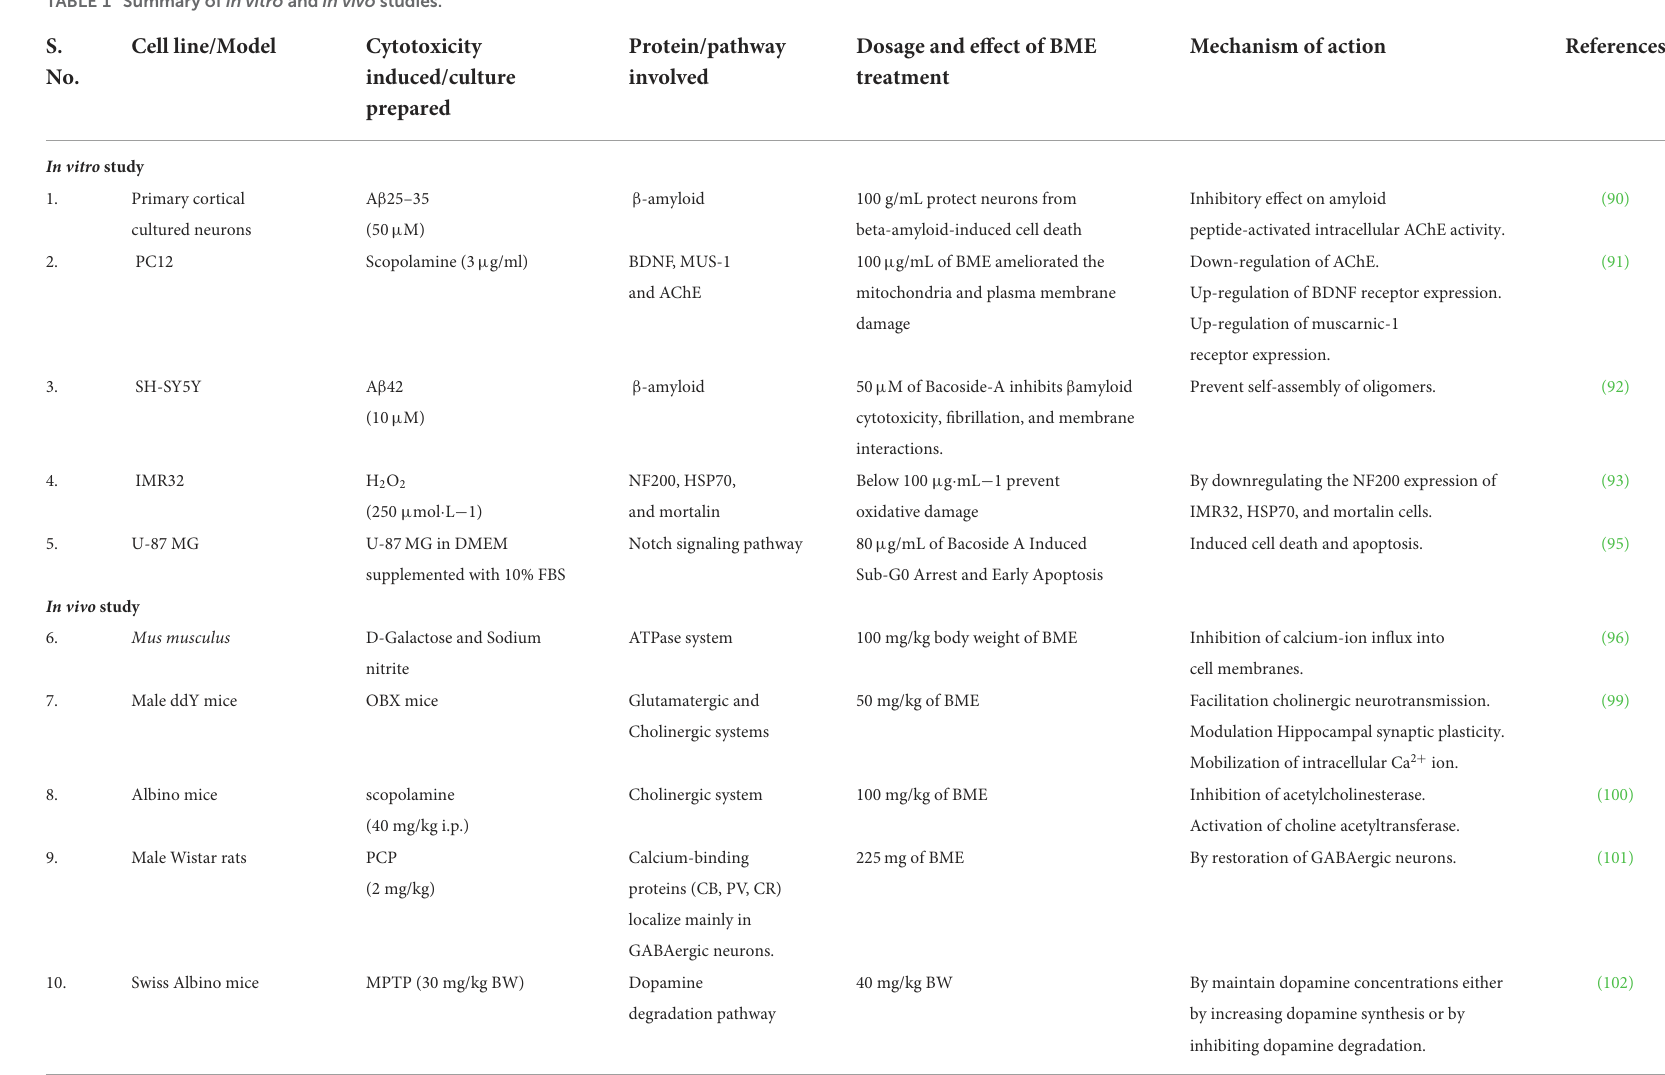
TABLE 1 Summary of in vitro and in vivo